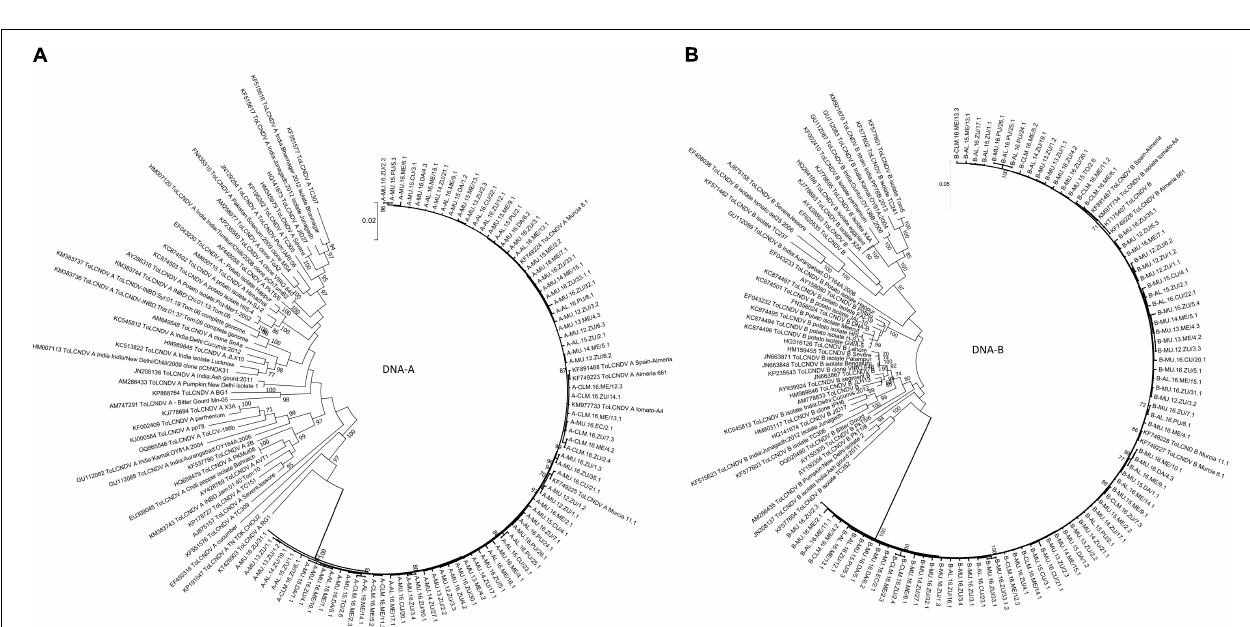
FIGURE 1 | Plant images showing virus-like symptoms of tomato leaf curl New Delhi virus (ToLCNDV) infection in cultivated and wild plant species. The top row shows symptomatic cultivated Zuchinni (A) , Cucumber (B) , and Melon (C) plants, where common symptoms include curling, yellowing and severe mottle mosaic in young leaves with plants that appear stunted in growth. The bottom row shows symptomatic wild Ecballium elaterium (D) , Datura stramonium (E) , and Solanum nigrum (F) plants, comprising curling leaves, chlorotic mottling and mosaic in young leaves, including yellow spots and pale green tissues.